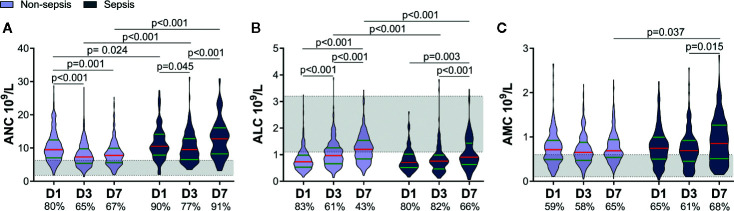
Patients who later developed sepsis had worse early alterations of circulating immune-cell counts. The proportions of patients with a value above the upper limit of the normal range (shaded area) of the absolute neutrophil count (ANC) and absolute monocyte count (AMC) or below the lower limit of the normal range of the absolute lymphocyte count (ALC) are shown on the x-axis (A–C). D1, day-1; D3, day-3; D7, day-7.